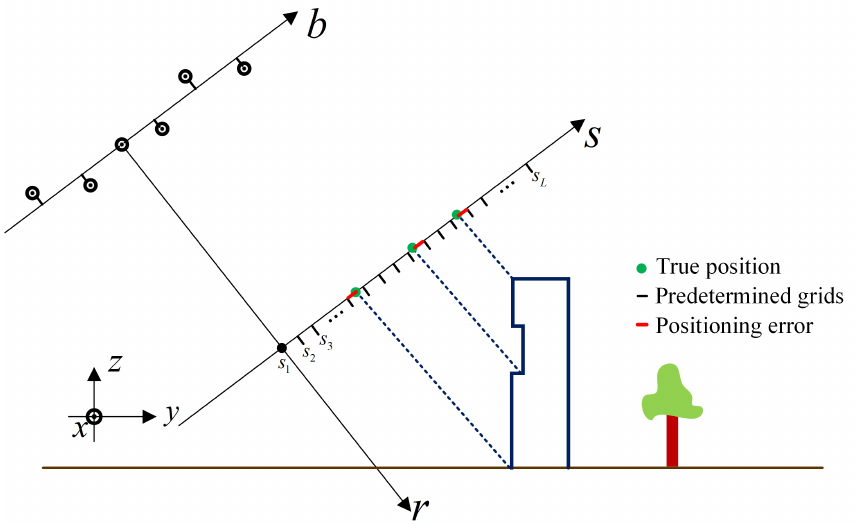
Figure 1. Diagram of the off-grid effect in TomoSAR elevation